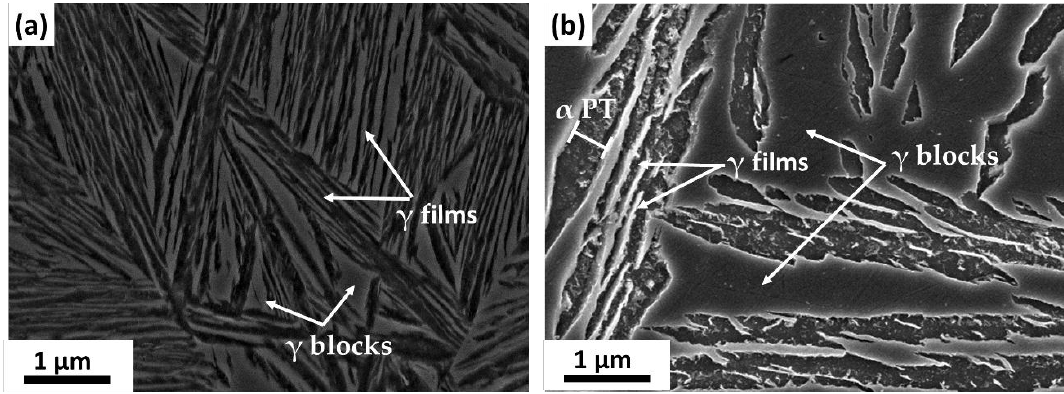
Figure 1. Secondary-electron scanning electron micrographs (SE-SEM) of two nanostructured bainites from the same steel, with chemical composition in reference [15], treated at 250 °C ( a ) and 350 °C ( b ). γ stands for austenite, and α PT, for bainitic ferrite plate thickness.